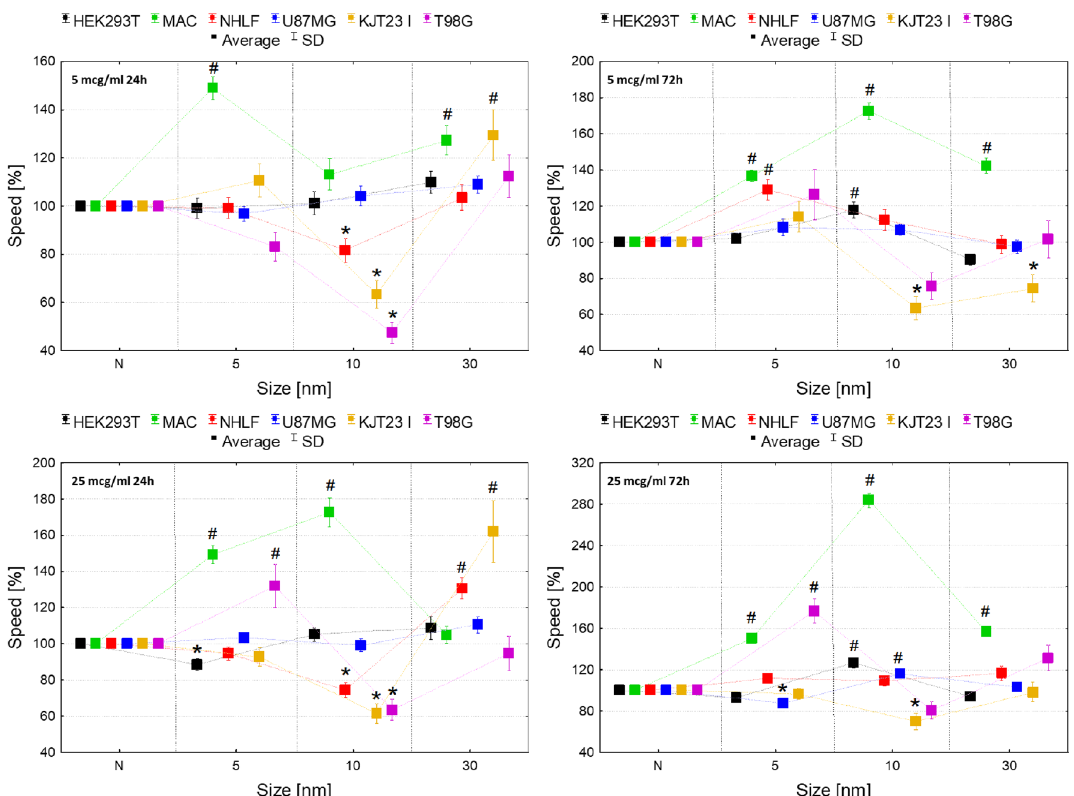
Figure 4. Normalized cell speed after 24 and 72-h exposure to IONPs with the diameter of 5 nm, 10 nm and 30 nm in the concentrations of 5 µg Fe/ml and 25 µg Fe/ml comparing to the control group (N). The statistically significant ( p < 0.05) increases of cell lines motility compared with corresponding N group were marked with “#” while decreases with “*”. The scales were adjusted for each chart so that data presented are the most The ROS activity of NHLF cells diminished significantly after 24 h from administration of 10 nm IONPs in dose of 5 µg Fe/ml. U87MG cells showed elevated ROS level when exposed to 5, 10 and 30 nm IONPs in the lower dose as well as after the treatment with 5 nm IONPs in the dose of 25 µg Fe/ml. Whereas after administration of 10 nm IONPs in a higher dose, ROS activity of this cell line decreased. The fluorescent images obtained for NHLF and U87MG cell lines are presented in the Fig. 8. The ROS production in KJT23I cells was significantly diminished after exposure to 5 nm IONPs in dose of 5 µg Fe/ml as well as 10 nm IONPs in both examined doses. T98G cells also demonstrated relevant decrease in ROS level after treatment with 10 nm IONPs in both doses but after administration of 5 nm IONPs in the higher dose, the ROS activity for this cell line was elevated. The changes in ROS levels in KJT23I and T98G cell lines are presented in Fig. 9. Analysis of changes in cytoskeleton architecture. The results obtained using a fluorescence micros- copy with TIRF module demonstrated changes in cytoskeleton organization and cell morphology for mac- rophages and U87MG line after the treatment with IONPs. For macrophages (Fig. 10) the observed effect seemed the strongest after 72-h long exposure to all IONPs in the dose of both 5 and 25 µg Fe/ml. The polarization of the cell body together with a decrease in the size and number of focal contacts were noticed. This phenomenon was not observed in the culture of untreated cells showing a more complex focal contacts architecture and relatively pronounced stress fibers (F-actin). For cancerous cell lines, the influence of IONPs on the architecture of selected elements of the cytoskeleton was not as evident. Nevertheless, U87MG cells exposed to the higher dose of IONPs with core sizes of 10 and 30 nm for both 24 and 72-h seem to present reduction in the number of focal contacts and stress fibers (Fig. 11). The remaining cell lines showed no response to the tested NPs in all concentration ranges in the context of architecture of the cytoskeleton rearrangements what one can see in the Figures S9-S12 of Supplementary materials presenting the results of immunofluorescence staining of F-actin and vinculin obtained for NHLF, HEK293T, T98G and KJT23I cells.